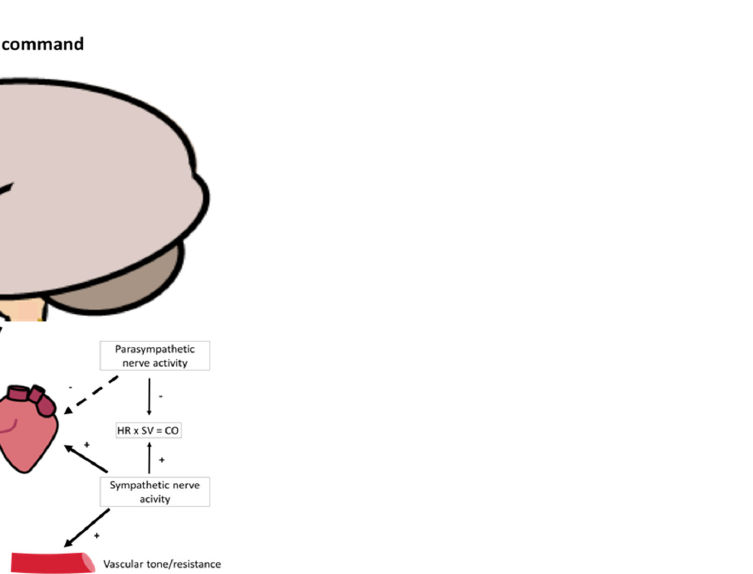
. Figure 2. An illustration of neural regulation of ventilation during exercise. Peripheral chemorecep- tors monitor the partial pressure of arterial O 2 in blood in response to acidosis (H + ) and carbon di- oxide (CO 2 ) (1), Metaboreceptors stimulate breathing during exercise (2), Central chemoreceptors monitor the partial pressure of arterial O 2 in blood, pH, and carbon dioxide (CO 2 ) (3), Mechanore- ceptors via spindles in the respiratory muscles (intercostal and diaphragm) measure the muscle length and increase the motor discharge (4).